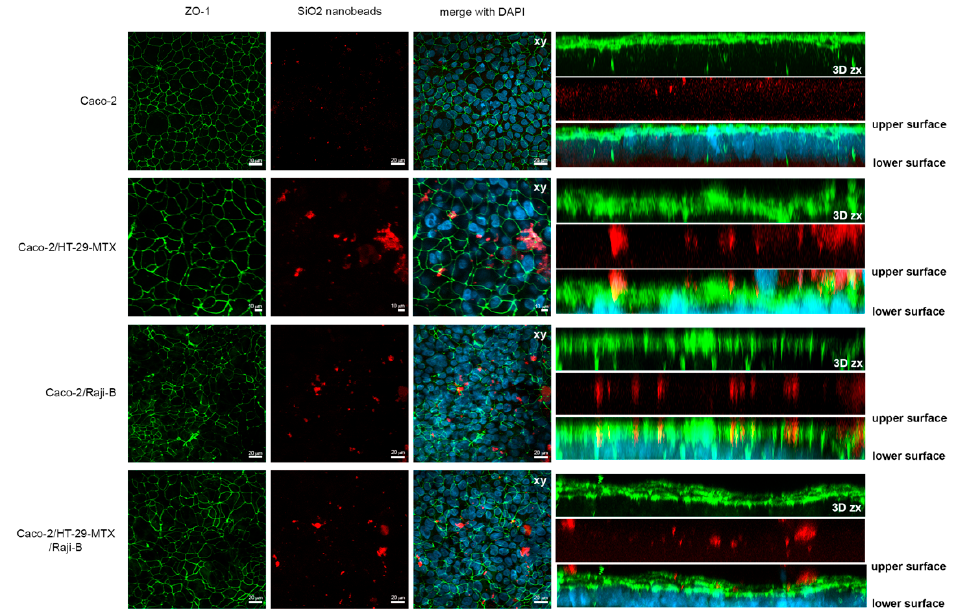
Figure 11. SiO 2 nanobeads (red) internalization in Caco-2 monoculture, Caco-2/HT29-MTX co- culture, Caco-2/Raji B co-culture, and Caco-2/HT29-MTX/Raji B tri-culture on 3 µ m pore insert. Cells were counterstained with DAPI (blue) and ZO-1 (green). Representative 3D reconstructions (Z-stacks) by CLSM are reported. 50–70 Z-slices were acquired every 0.20 µ m covering the total height of the cell cultures on inserts. Left panels show xy Z-stack projections, while right panels show xz Z-stack projections; the upper and the lower surface of inserts are indicated. Scale bars are 20 and 10 µ m, as indicated.